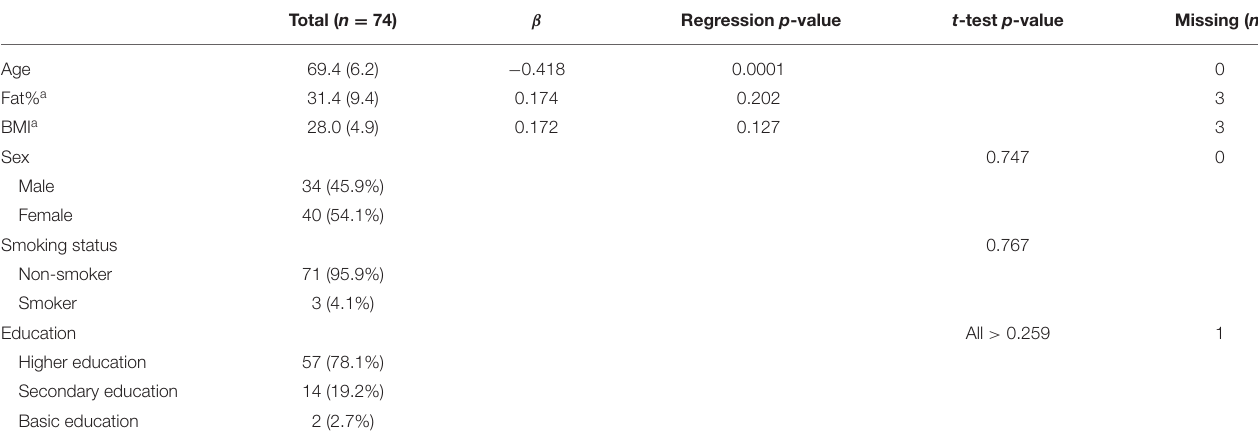
TABLE 2 | Subject characteristics and their relation to MoCA score.